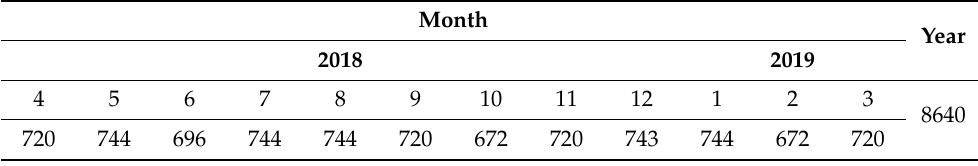
Table 3. The amount of data per month and